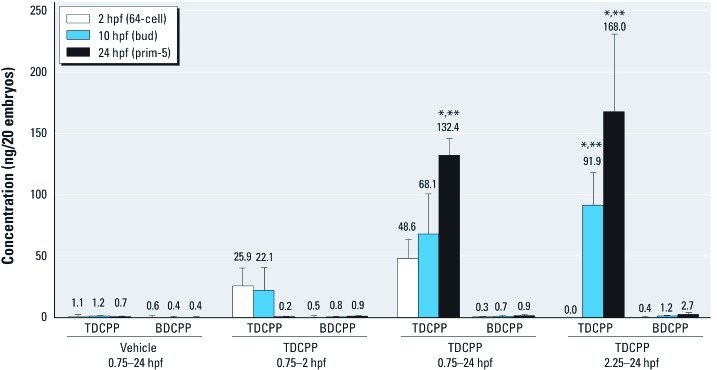
Mean (± SD) TDCPP or BDCPP concentration (ng) detected in homogenates of 20 whole embryos exposed in triplicate to vehicle (0.1% DMSO) from 0.75 hpf (2‑cell) to 24 hpf (prim-5) or to 3 µM TDCPP from 0.75 hpf (2‑cell) to 2 hpf (64‑cell), followed by incubation in vehicle until 24 hpf (prim-5); 0.75 hpf (2‑cell) to 24 hpf (prim-5); or 2.25 hpf (128‑cell) to 24 hpf (prim-5). n = three replicate embryo pools per treatment and time point. TDCPP levels within embryos exposed during 0.75–2 hpf alone were nondetectable by 24 hpf. *p < 0.05 for within–exposure window differences in concentration compared with vehicle controls. **p < 0.05 for within-treatment differences in concentrations relative to 2-hpf embryos.